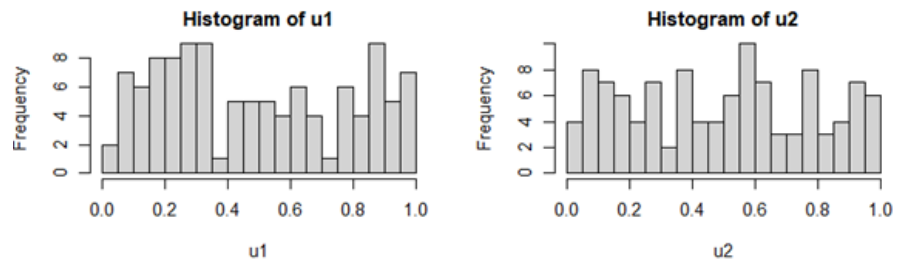
Figure 2. Example uniform marginal distributions estimated from an empirical